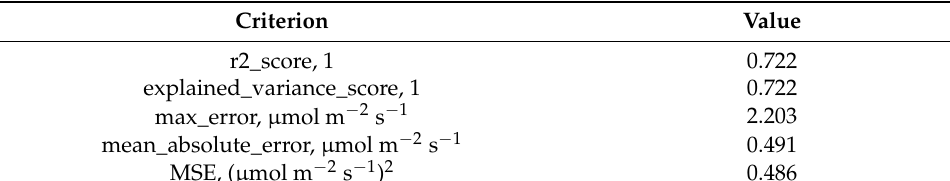
Table 2. The results of experiment 2.